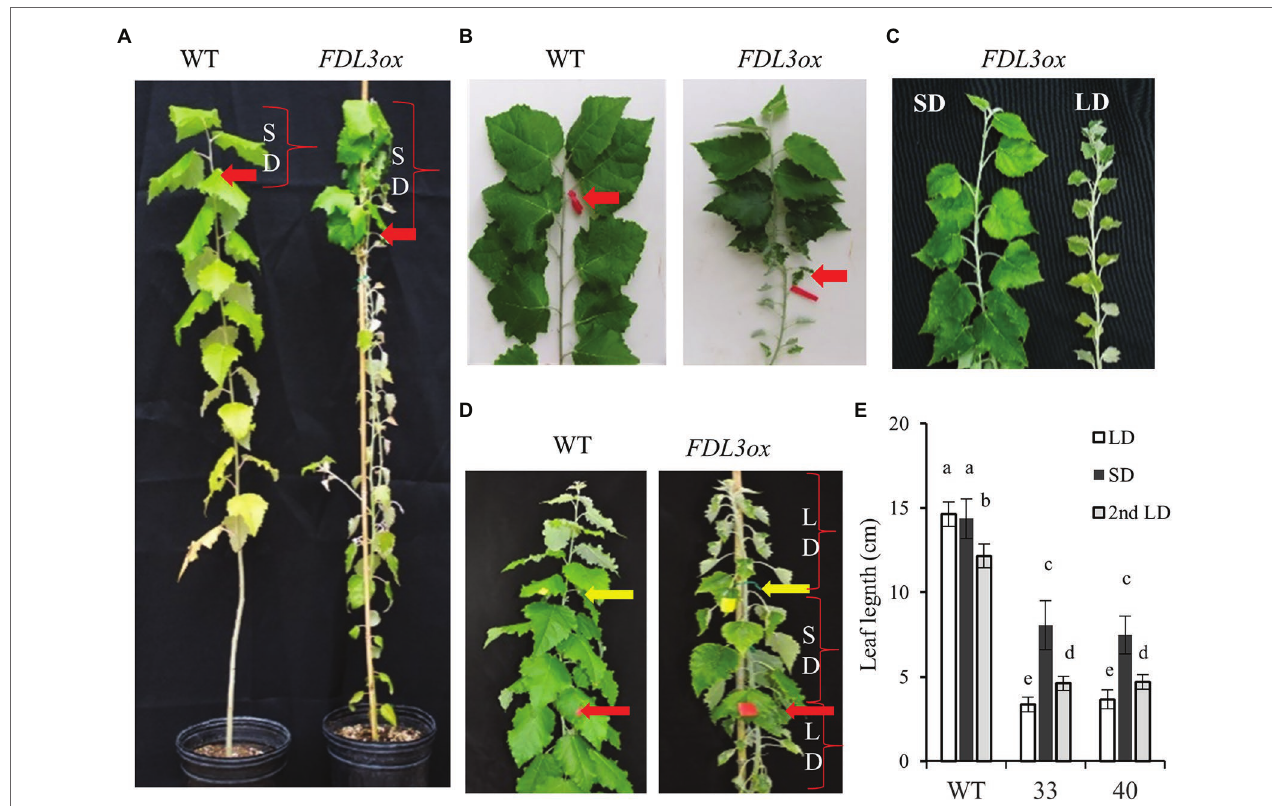
FIGURE 7 | FDL3ox trees resume leaf development in short days. (A,B) Both FDL3ox and WT plants were grown in a long day (LD) greenhouse for 6 months and then were transferred into a SD growth chamber for 8 weeks. FDL3ox leaves formed after transfer to SDs (above the red arrows) showed leaf development similar to actively growing WT plants, in contrast to underdeveloped leaves formed on FD3ox plants in LDs (below the red arrows). Plants (A) and shoots (B) were imaged after 8 weeks exposure to SDs. (C) Shoots from ramets of the same FDL3ox event grown 8 weeks in SDs or LDs. (D,E) The changes in leaf expansion size of FDL3ox plants followed the changes of photoperiod duration. (D) FDL3ox and WT plants were grown for 2 months in LDs (below the red arrows), followed by 4 weeks of SDs (between red arrows and yellow arrows), and then 3 weeks of LDs (above the yellow arrows). (E) Fully expanded leaf length of WT and FDL3ox plants formed in SDs and LDs. Six fully expanded leaves were measured for each plant. Leaf length is mean ± SE ( n = 4); different letters indicated significant differences, p < 0.0001, Tukey–Kramer’s